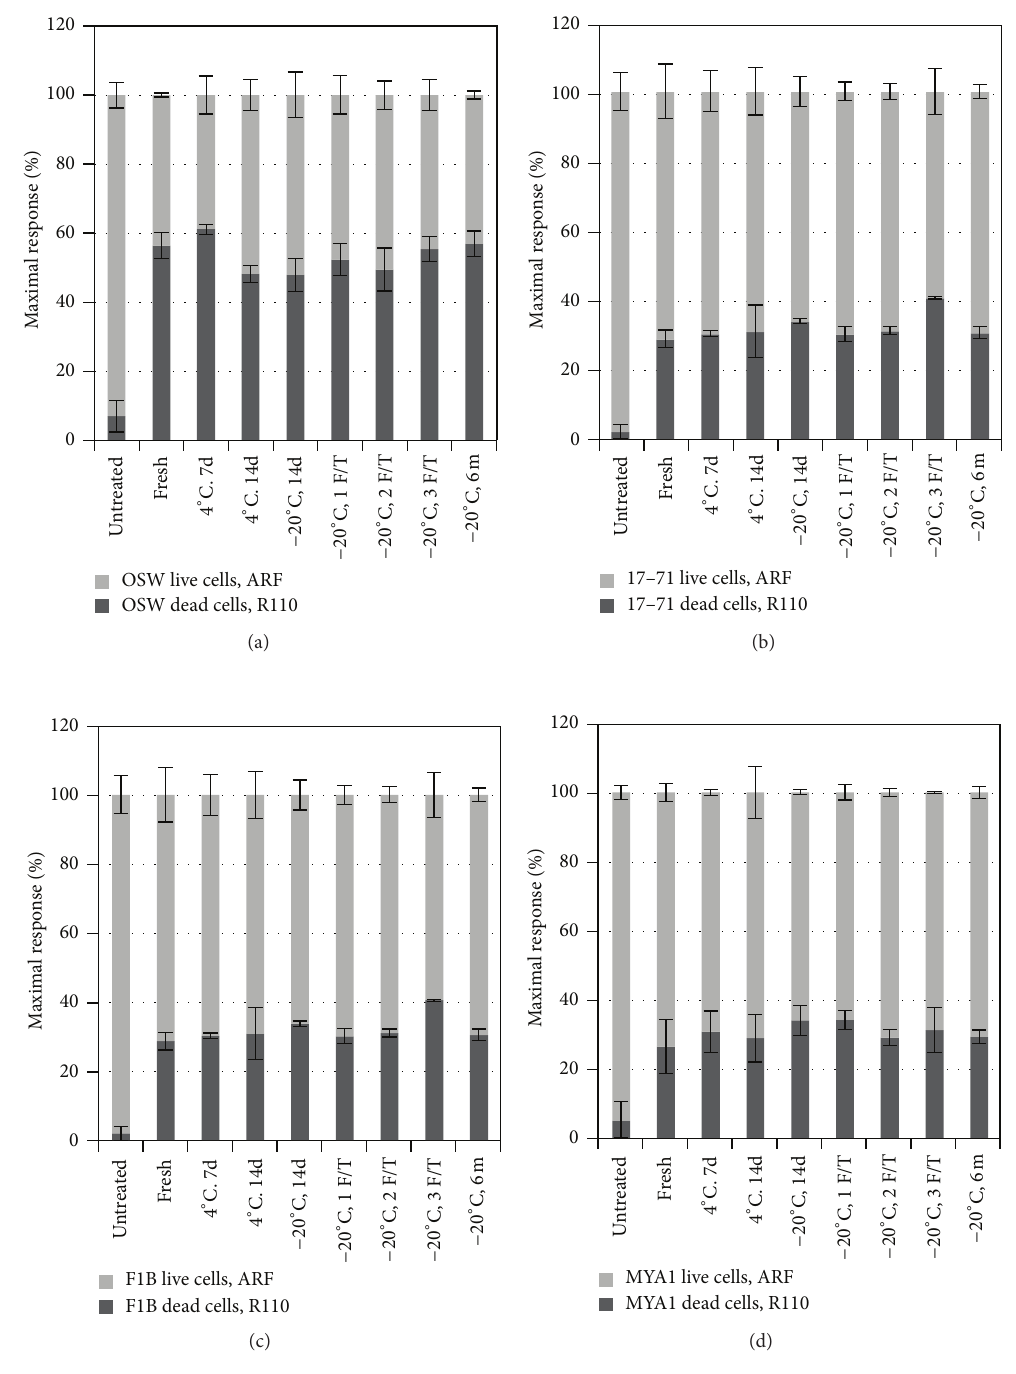
Figure 2: ASNase increases cytotoxicity in vitro . All cold-stored asparaginase treatment groups increase cell cytotoxicity, 𝑃 < 0.05 . (a) OSW canine cells, (b) 17–71 canine cells, (c) F1B feline cells, and (d) MYA1 feline cells. Cell lines demonstrate variable response to ASNase effects.